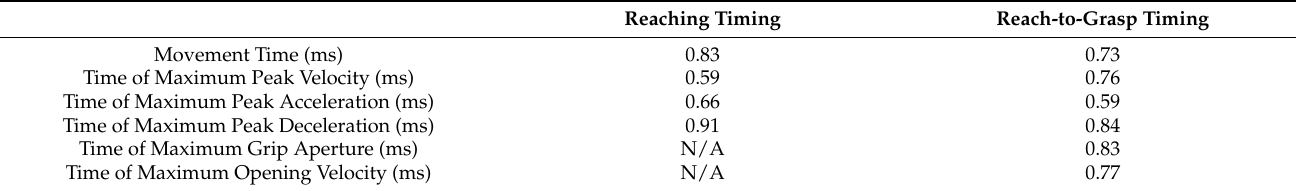
Table 2. Weights of the kinematic parameters for the components of the reaching and the reach-to- grasp